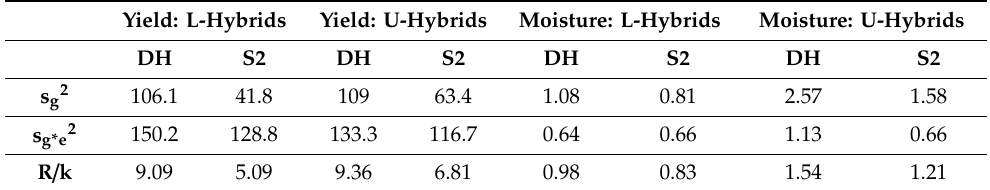
Table 2. Estimates of variances and response for yield and grain moisture, DH vs. S2 hybrids with the L and U testers, data from five Midwest US locations in